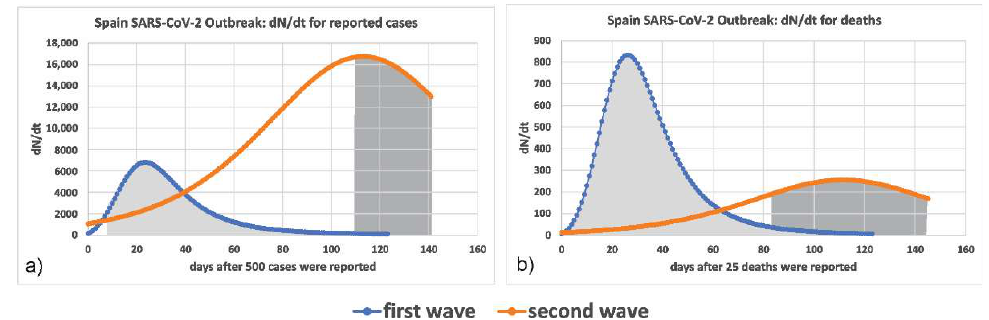
Figure 3. The rate of the ( a ) reported infected cases and ( b ) total number of deceased (dN/dt) for the first and second waves in Spain. The shaded areas indicate the lockdown periods.